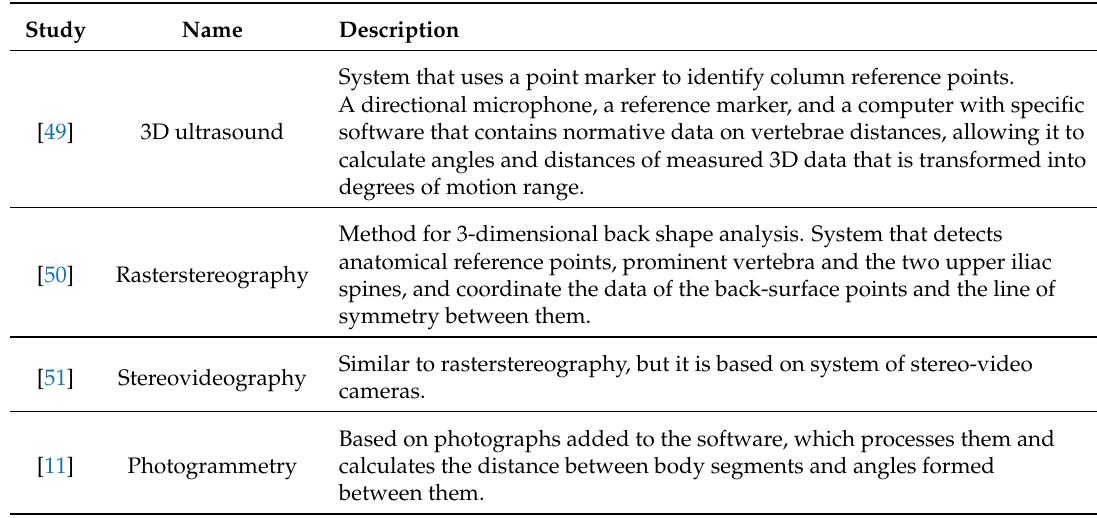
Table 3. Summary of software-aided assessment tools for human postural